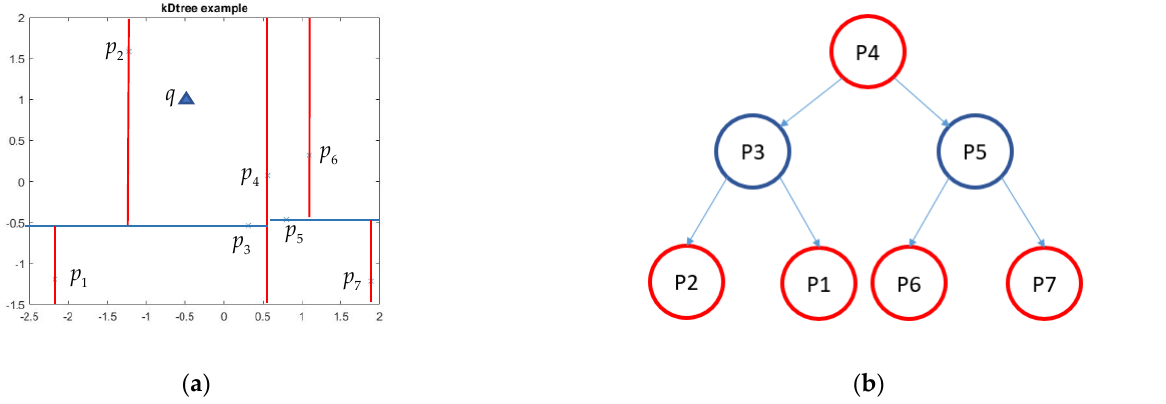
Figure 2. Illustration of kD-tree construction and nearest point search from the kD-tree: ( a ) two-dimensional dataset which has been split based on binary space partitioning; ( b ) representation of a kD-tree as a binary tree.